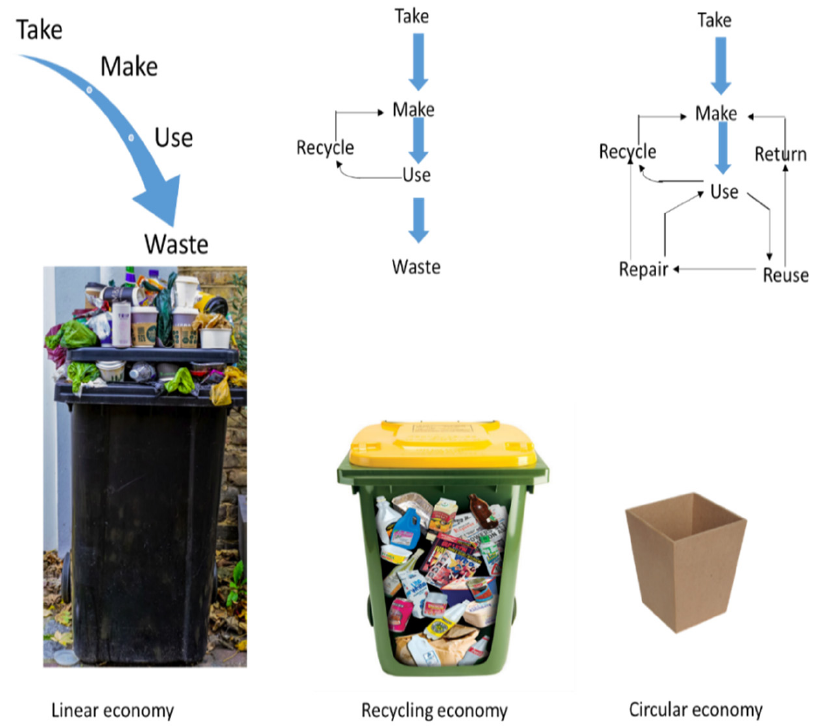
Figure 2. Circular economy of waste products (modified from the Asian Development Plan, 2020).